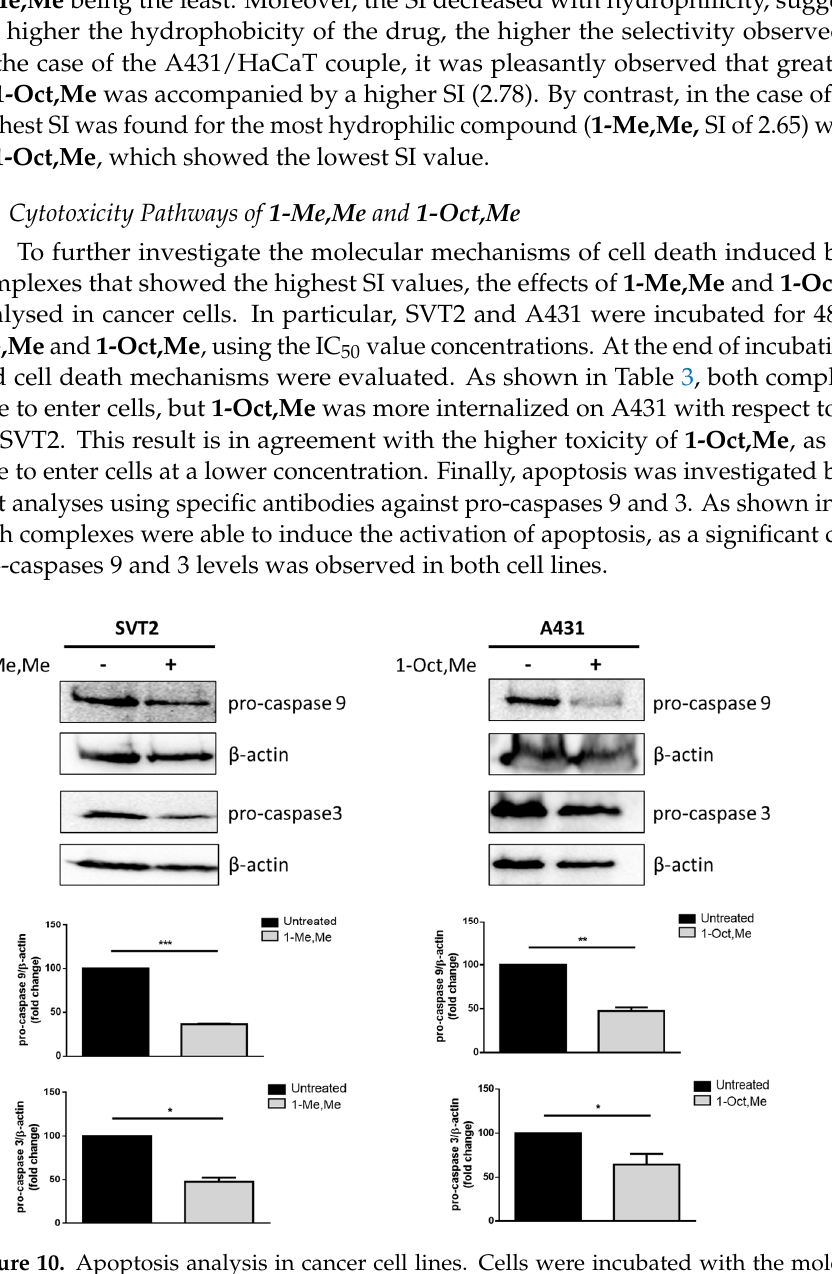
Figure 10. Apoptosis analysis in cancer cell lines. Cells were incubated with the molecule being tested, with each one at its IC 50 value (9.8 µ M 1-Me,Me on SVT2 and 2.3 µ M 1-Oct,Me on A431). After 48 h, protein extracts were analysed by Western blot using anti-pro-caspases 9 and 3. β -actin was used as the loading control. The densitometric analysis is reported below the Western blot images. Black bars, untreated cells; grey bars, treated cells. Data shown are the means ± S.D. of three independent experiments. * indicates p < 0.05; ** indicates p < 0.01; *** indicates p < 0.001 with respect to untreated